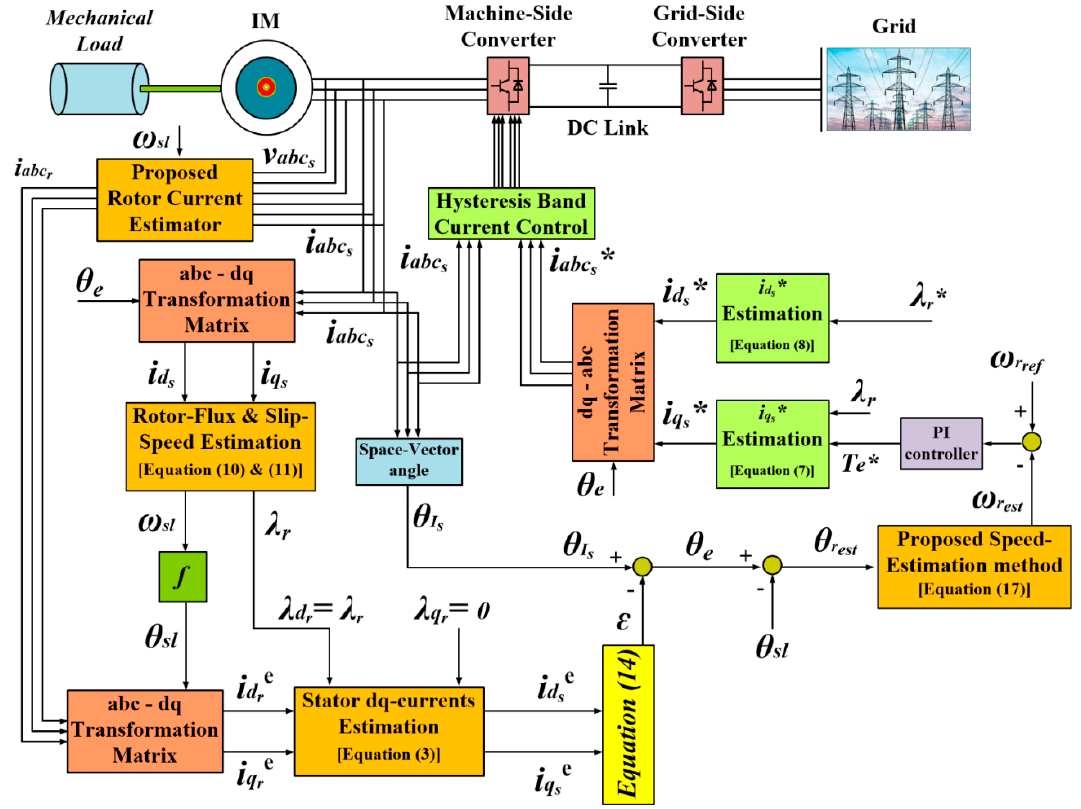
Figure 4. Conceptual diagram of the adopted sensorless control system.